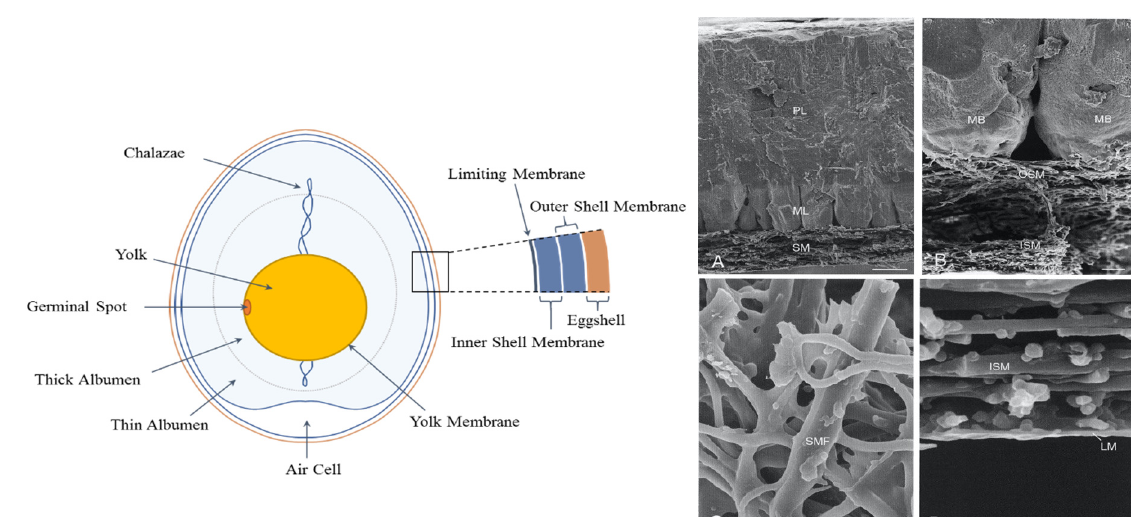
Figure 1. Hen egg structure and scanning electron micrographs illustrating the morphology of the eggshell and eggshell membranes. ( A ) Eggshell cross-fractured to reveal the shell membrane (SM), mammillary layer (ML), and palisade layer (PL); ( B ) higher magnification of the membrane mammillary body interface: Outer shell membrane fibers (OSM); insert into the tips of the mammillary bodies (MB); inner shell membranes (ISM); ( C ) enlargement of the shell membrane fibers (SMF), revealing their interwoven and coalescing nature; ( D ) inner aspect of the inner shell membrane (ISM), demonstrating the limiting membrane (LM) that surrounds the egg white here removed during sample preparation. Scale bars: ( A ), 50 mm; ( B ), 20 mm; ( C , D ), 2 mm. (adapted from M.T. Hincke et al., Matrix Biology, 19, 443–453, 2000, [5]).